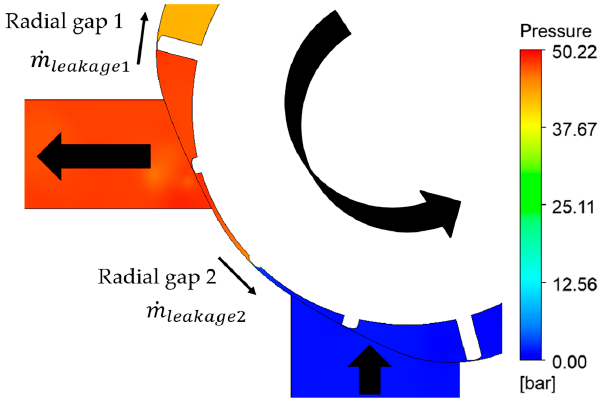
Figure 3. Internal leakage paths from outlet 1 to inlets 1 and 2 at 30 ◦ shaft rotation angle.